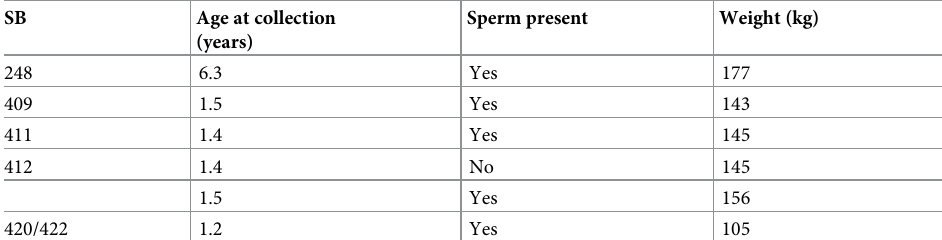
Table 4. Detection of spermatozoa in urine from lions of varying